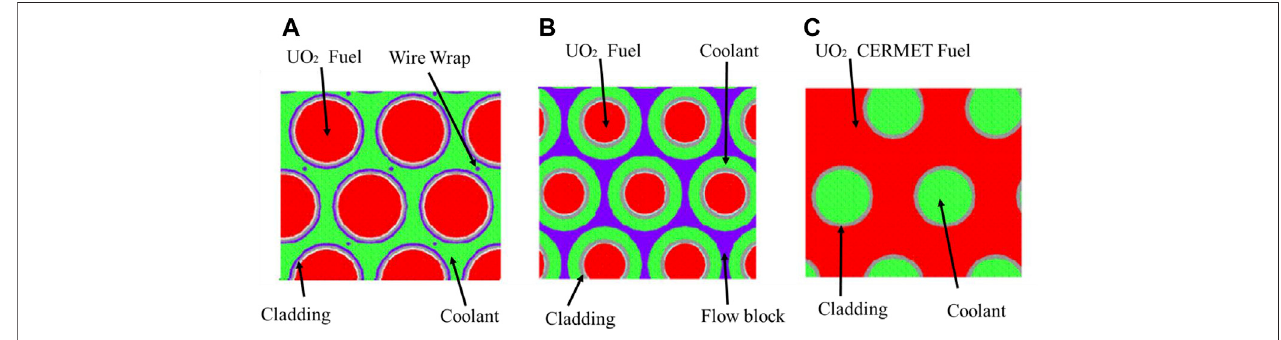
FIGURE 1 | Core arrangement options [Ashcroft, J., and C. Eshelman. 2006]. (A) Open lattice, (B) Pin in block, (C) Monoblack.